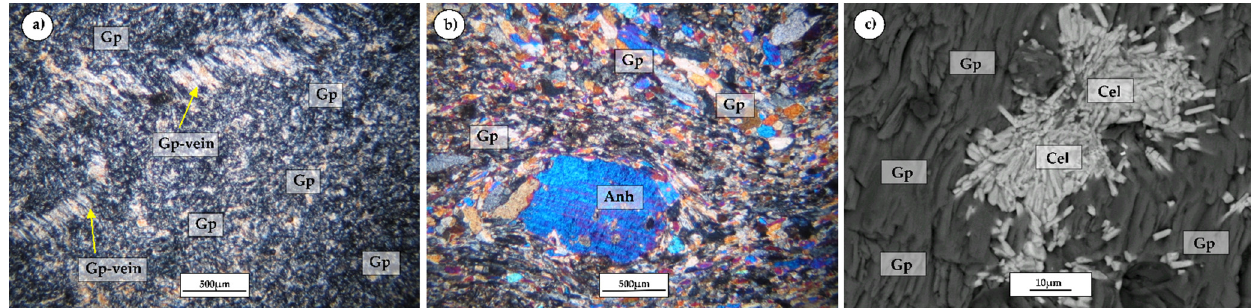
Figure 2. Crossed polars photomicrographs of: ( a ) Gypsum-rich sample SK-2 composed of alabastrine gypsum, with veins filled with oriented gypsum crystals. ( b ) Gypsum-rich sample KAS-1 composed of alabastrine to granoblastic gypsum. Oversize crystal and residues of anhydrite crystals appear, with the form of boudinage. ( c ) Celestite crystals of irregular and prismatic form and at radial layout within the gypsum mass (gypsum-rich sample FIL-2). (Gp: Gypsum, Anh: Anhydrite, Cel: Celestite).